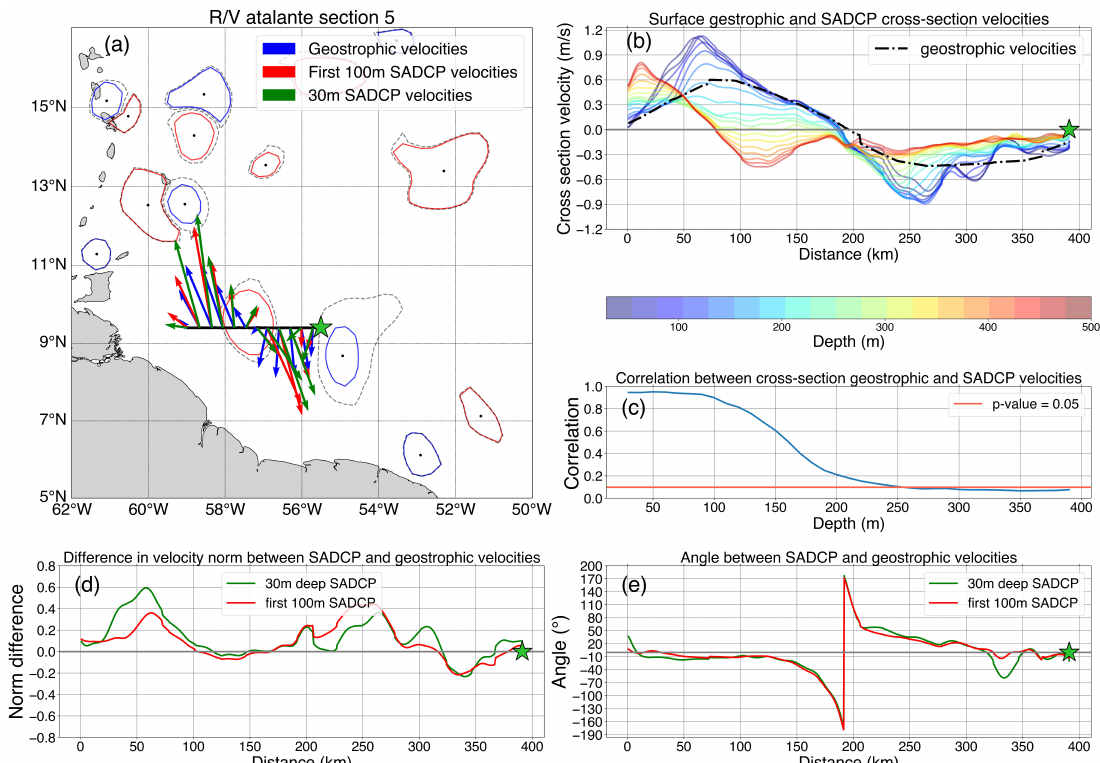
Figure 7. Comparison between S-ADCP and surface geostrophic velocities derived from satellite altimetry for R/V L’Atante Section 5. ( a ) Ring A2 section, with maximum velocity contour in red (blue) for anticyclones (cyclones) and outermost contour in dotted black line. Surface geostrophic velocities are shown in blue arrows, the first 100 m averaged S-ADCP velocities are in red, and the 30 m depth velocities are in green. ( b ) Cross-section surface geostrophic velocities are shown in dotted black lines and cross-section S-ADCP at different depths are shown in jet colors. ( c ) Pearson coefficient correlation between Surface geostrophic and S-ADCP velocities plotted as a function of depth. ( d ) Difference in velocity norm between surface geostrophic and S-ADCP velocities at